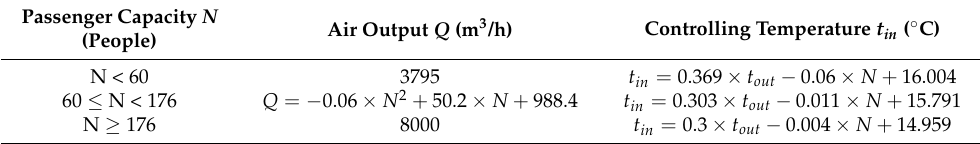
Table 10. The air-supply volume and the temperature-control curve. Passenger Capacity N